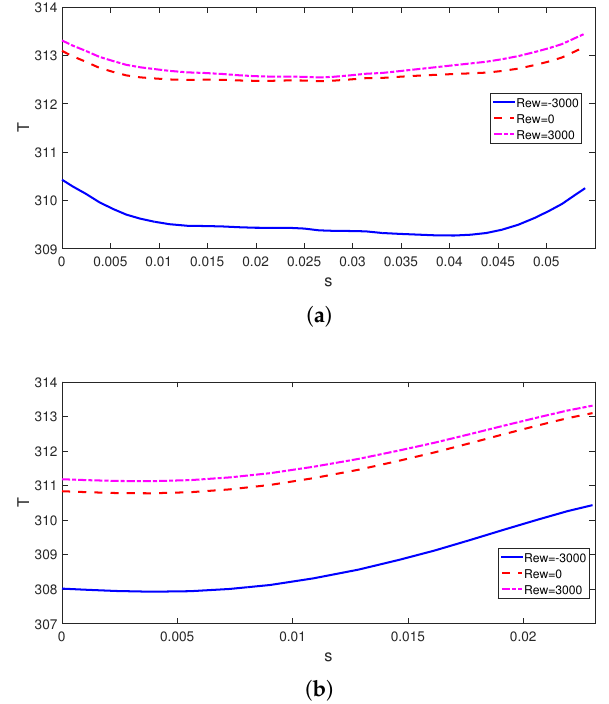
Figure 6. Variation of the IT in the x ( a ) and y ( b ) directions at several Rew values using NF1 (R = 0.18 Hm, (Yp, Zp) = (0.5,